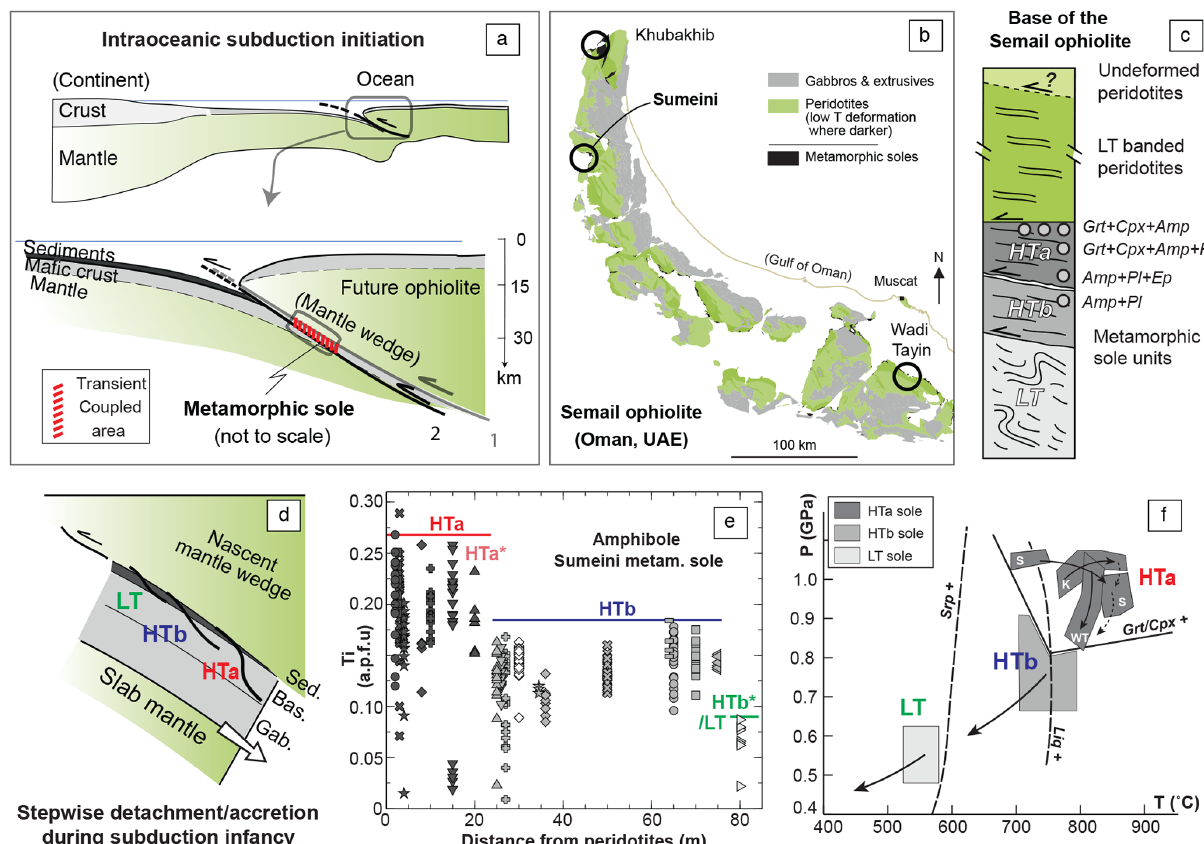
Figure 1. (a) Geodynamic setting of metamorphic sole formation during intraoceanic subduction infancy (modified after Agard et al., 2016); (b) simplified geological map of the Semail ophiolite, highlighting the outcrops of metamorphic sole beneath the ophiolite mantle (modified after Nicolas et al., 2000); (c) schematic log of the base of the Oman ophiolite showing the structural position of the samples from Khubakhib (K), Sumeini (S) and Wadi Tayin (WT). See Table 1 for details; (d) close-up view of the tectonic configuration along the nascent plate interface, during the formation and exhumation of the HTa, HTb and LT soles until reaching the steady state (sketch modified after Agard et al., 2016, and Soret et al., 2017); s: sediment, b: basalt, g: gabbro, m: mantle peridotite; (e) amphibole Ti vs. Si content in amphibolite samples from Sumeini (after Soret et al., 2017) outlining the discontinuous decrease in T conditions during the exhumation of the HT metamorphic sole; (f) compilations of P – T estimates and associated P – T paths (after Soret et al., 2017) from the Grt–Cpx amphibolite (HTa) to the Pl-rich amphibolite (HTb) and greenschist facies (LT) metamorphic sole